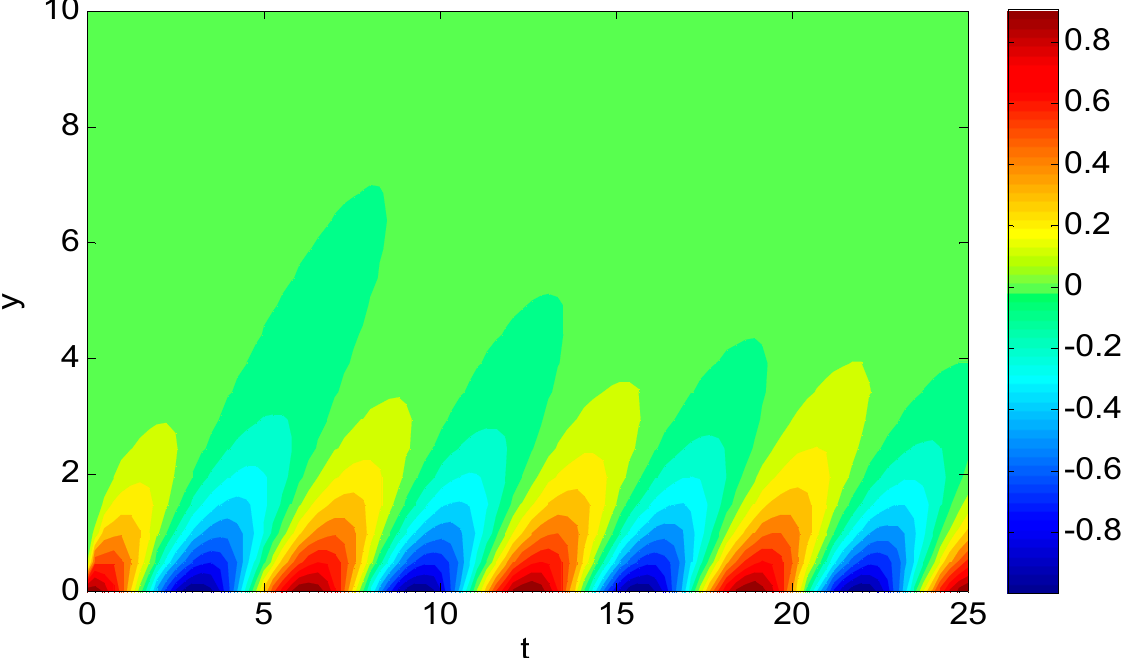
Figure 11. Contour plot for velocity profile of Stokes’ second problem in Quantum Calculus by the proposed scheme for spatial direction and Crank–Nicolson scheme for time direction using N y = 50, N t = 100, q = 0.8, λ = 0.01, β = 0.01, Pr = 0.9, L =